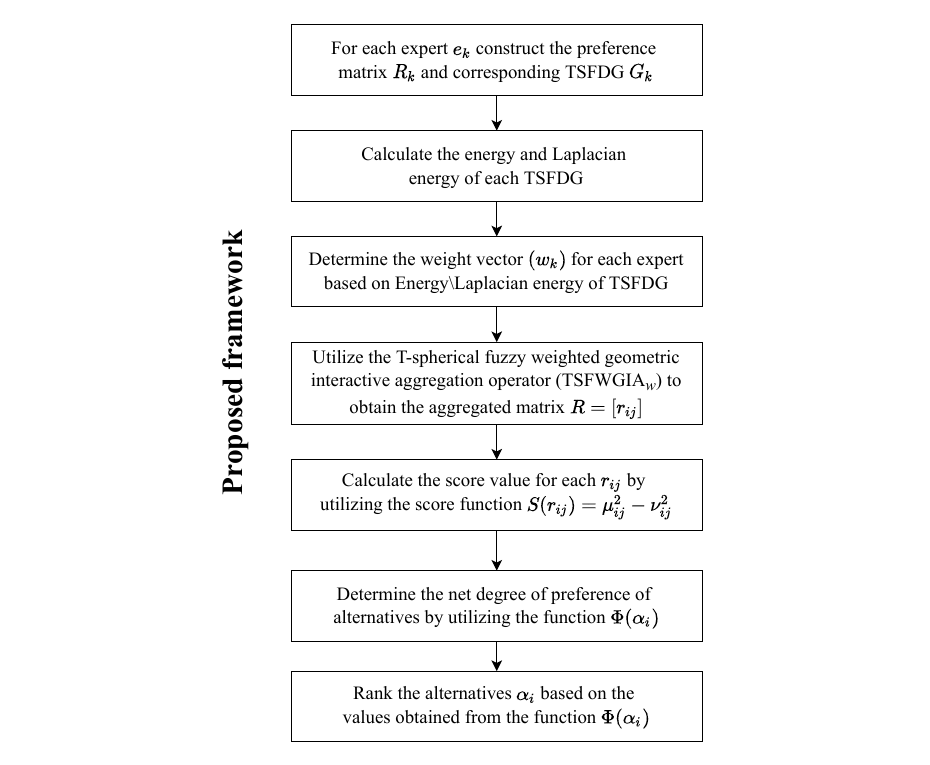
Figure 1. Flow chart of algorithm for alternatives selection